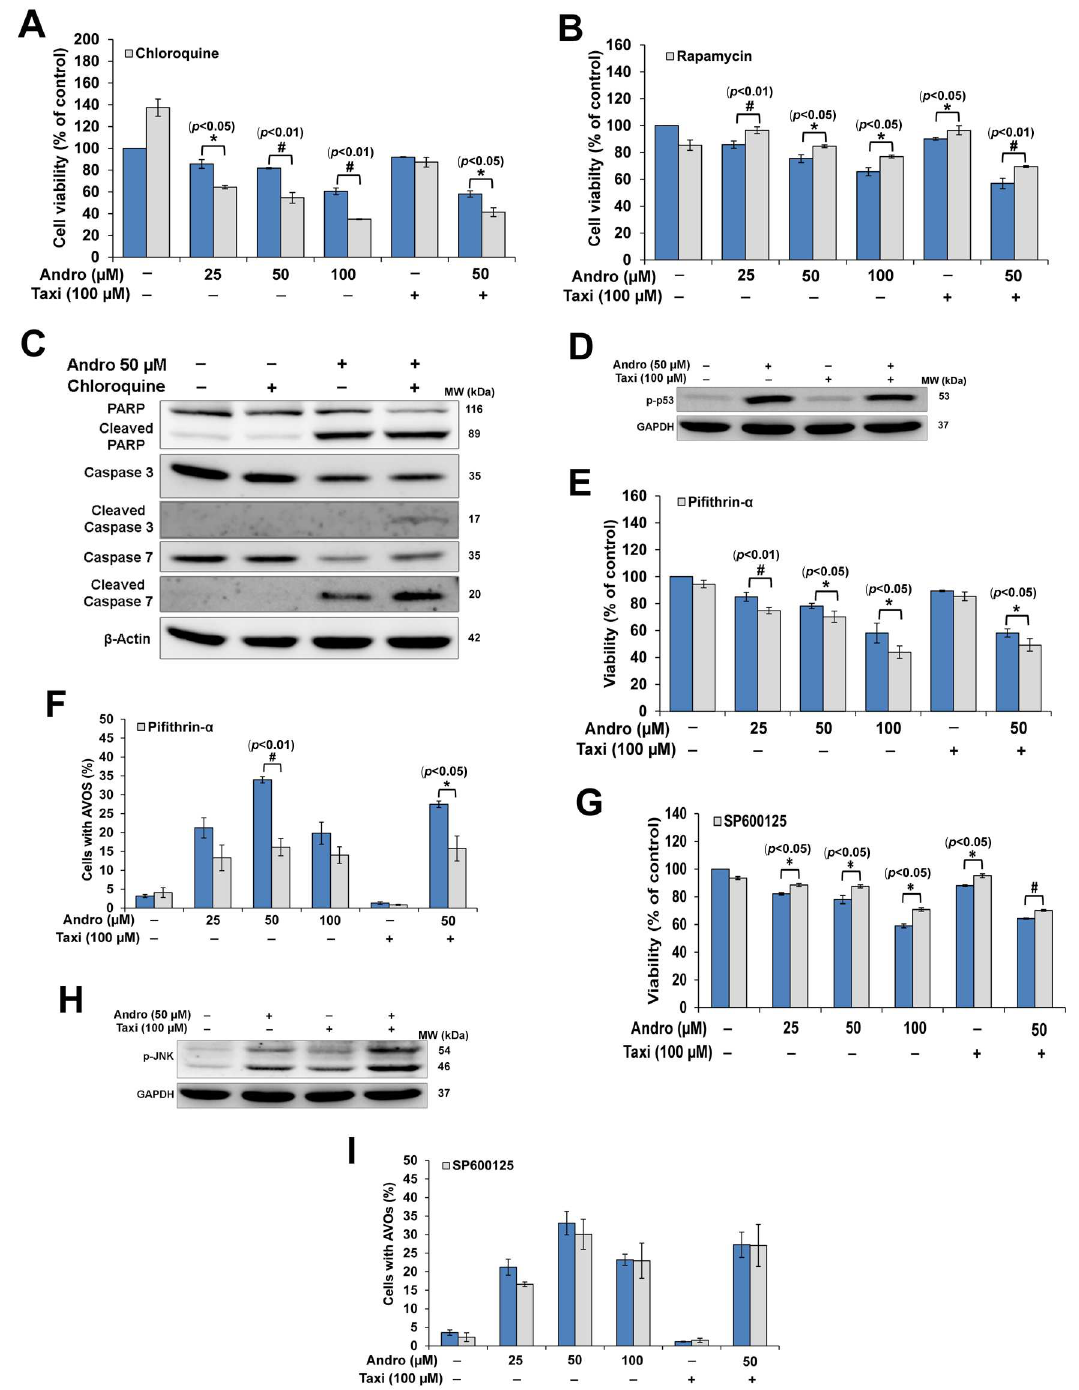
Fig 5. Inhibition of protective autophagy augmented apoptosis in HeLa cells via reduction of p- p53. (A & B) The cells were treated with different concentrations of Andro, 100 μ M Taxi or 50 μ M Andro combinedwith 100 μ M Taxi for 24 h with or without 1 h pretreatment with CQ (5 μ M) or Rapamycin (0.5 μ M). The cell viabilitywas tested using the MTT assay. Values from each treatment were compared to the control values and expressedas mean ± SD of three independent experiments. (C) Apoptosis as illustratedby cleavageof PARP and caspases3 and 7 following24 h Andro treated Hela cells with or without 1 h pretreatment with CQ (5 μ M). (D) Effect of Andro and/or Taxi on p-p53 protein levels. GAPDH was used to ensure equal protein loading.(E) Effect of Andro and/or Taxi in the presenceor absenceof PFT- α on